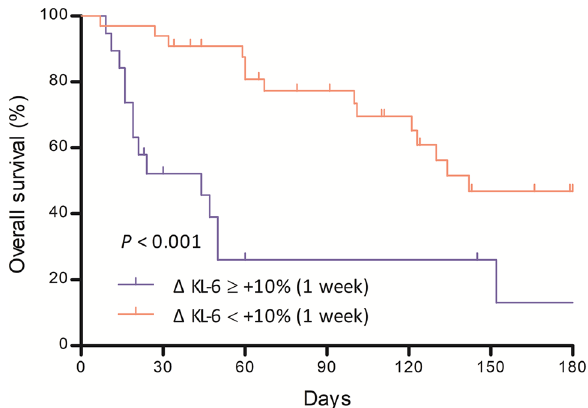
Figure 3. Comparison of survival curves after hospitalization between groups with high and low changes in KL-6 among patients with AE-ILD. Kaplan–Meier curves: blue line, high KL-6 change group; red line, low KL-6 change group. KL-6 Krebs von den Lungen-6, AE-ILD acute exacerbation of interstitial lung